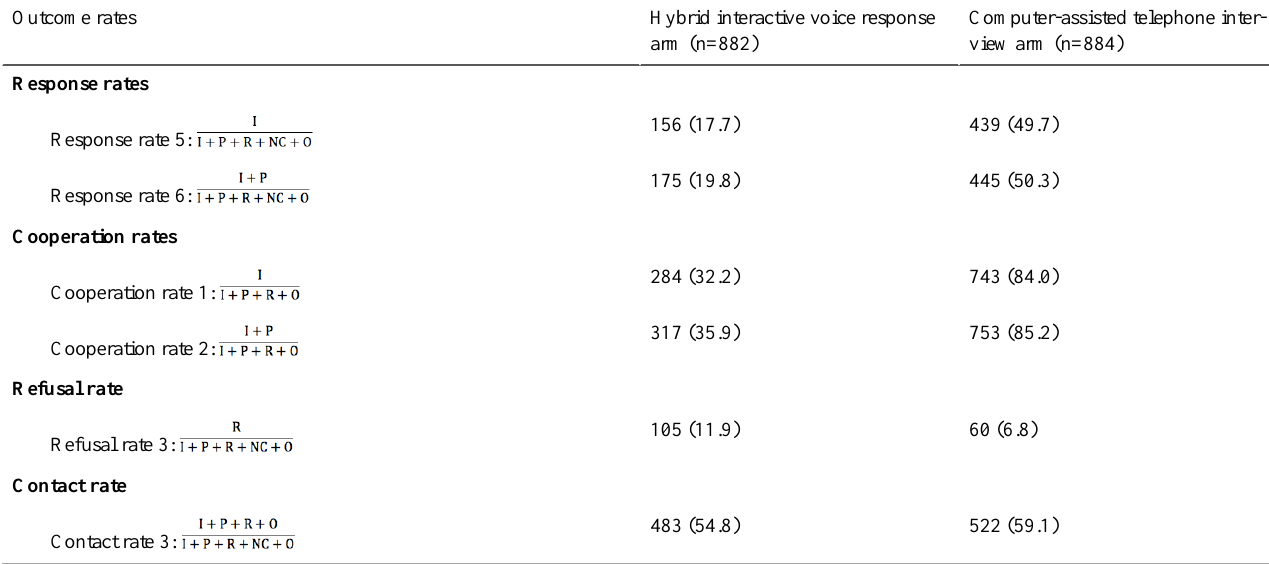
Table 3. Follow-up phone call outcome rates by study arm (computer-assisted telephone interview vs hybrid interactive voice response) among female cell phone owners in Burkina